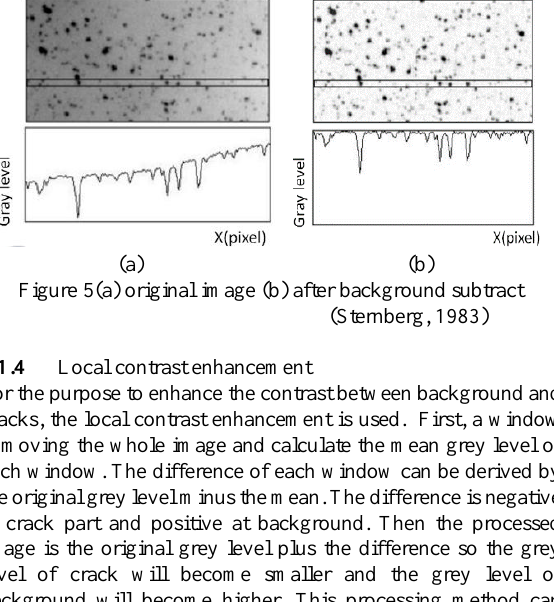
Figure 7. The comparison between a straight line and a zigzag